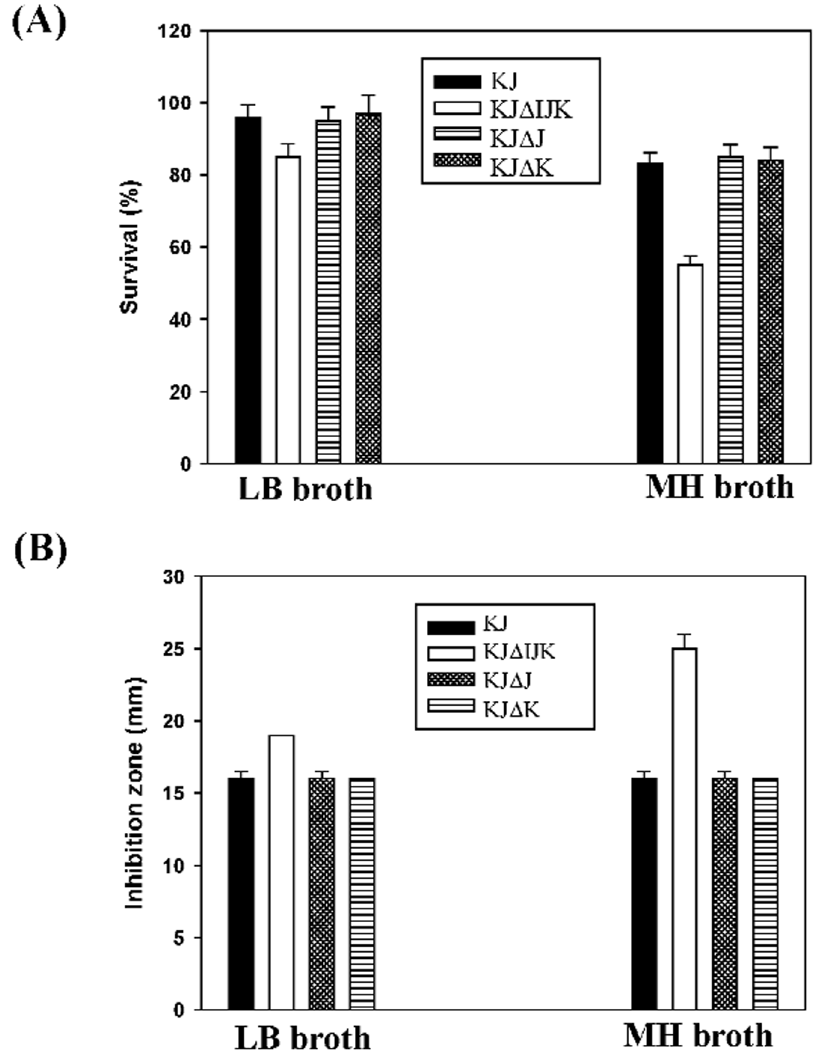
Figure 3. Assessment of the cell envelope integrity of S.maltophilia KJ and its derived mutants in different cultured conditions. (A) Sodium dodecyl sulfate (SDS) survival analysis. The survival of KJ, KJ D IJK, KJ D J, and KJ D K in LB or MH broth without or with 0.02% SDS was determined by the A 450 nm measurement. The percentage of survival was defined as the A 450 nm ratio of the SDS-additive group to the SDS-free counterpart. (B) Polymyxin E susceptibility. The polymyxin E susceptibility of KJ, KJ D IJK, KJ D J, and KJ D K in LB or MH broth was determined by the